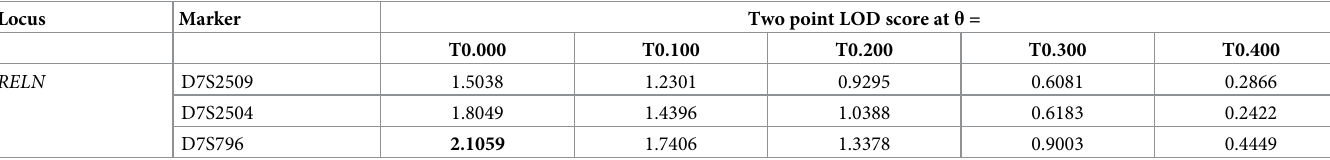
Table 2. Two-point LOD score estimation for RELN loci in an OTSC family. Locus Marker Two point LOD score at θ =